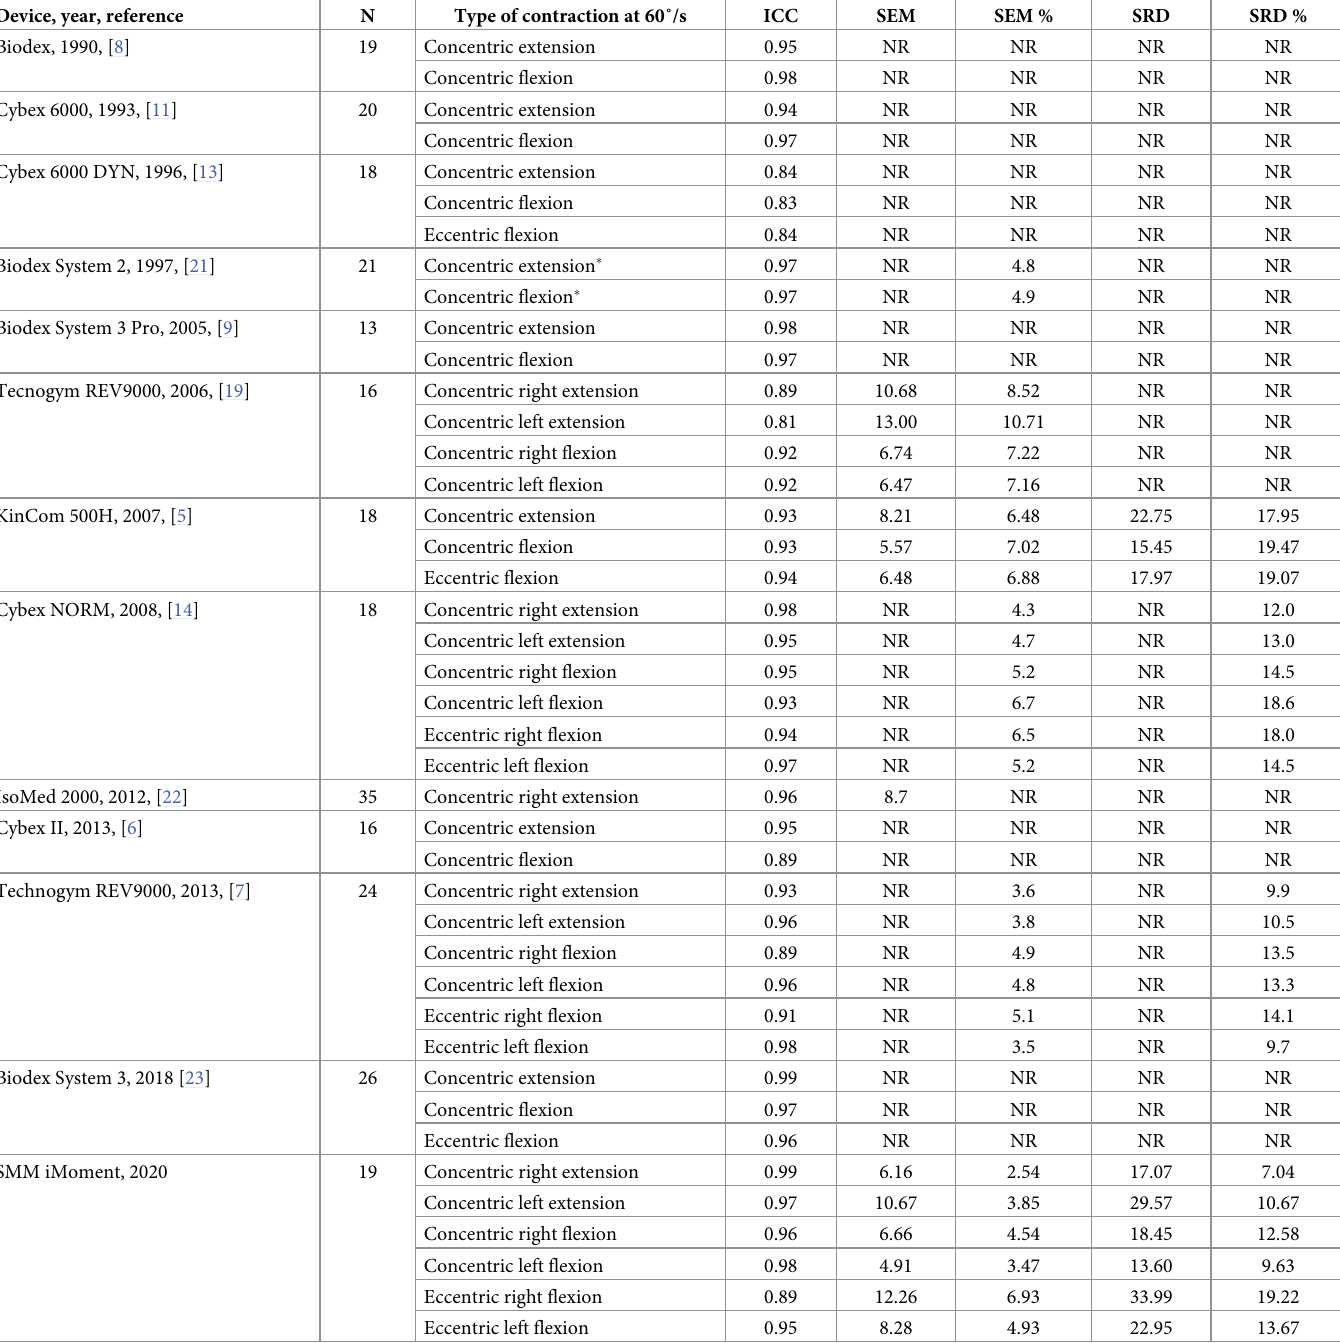
Table 3. Overview of current studies examining absolute and relative reliability using different isokinetic dynamometers. Device, year,